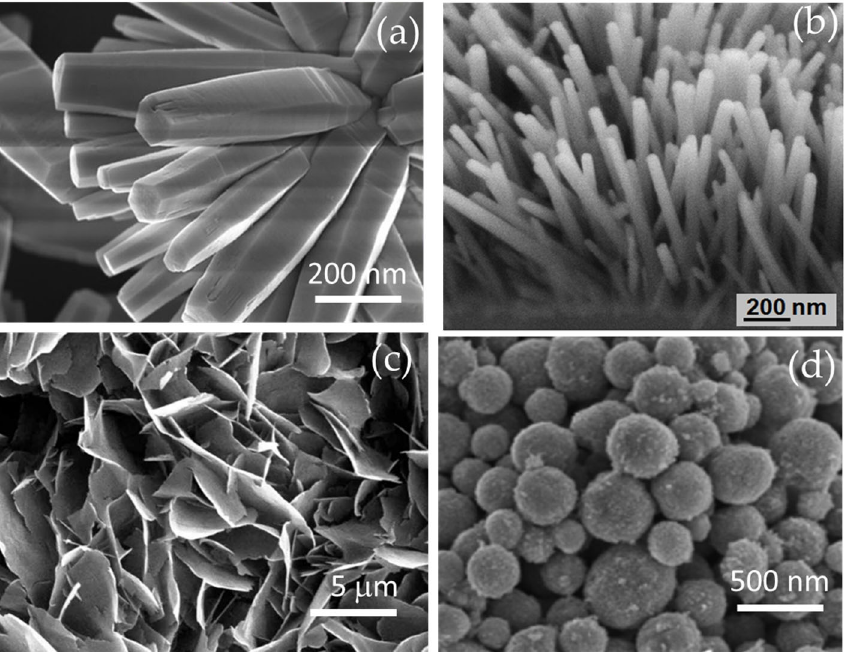
Figure 4. ZnO ( a ) nanoflowers, ( b ) nanorods, ( c ) nanoflakes, and ( d ) nanospheres. Reproduced from ref. [54,58–60] with permission from the publishers (Springer Nature, 2015; PLOS ONE, 2020; Science Publication, 2009; IOP Publishing, 2020).